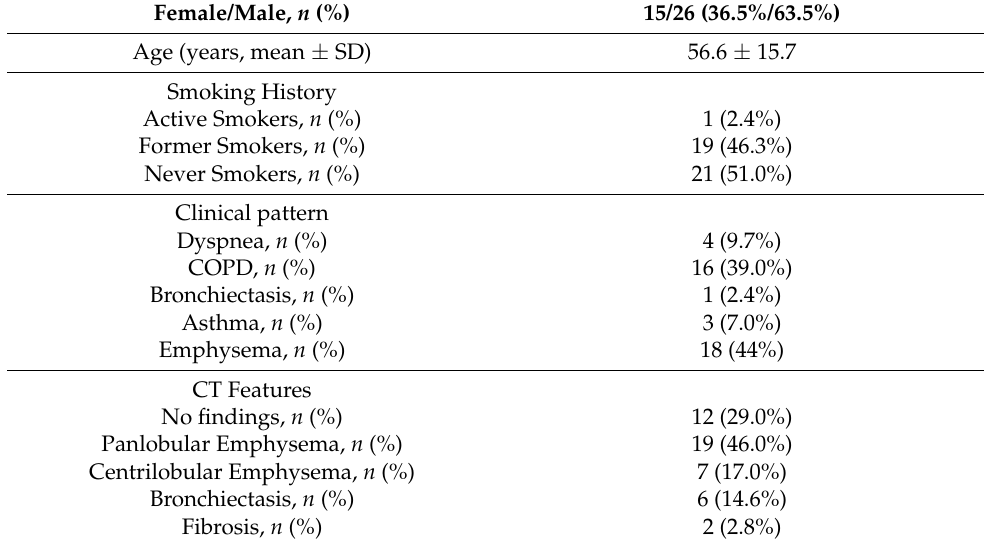
Table 1. Patients’ characteristics. Out of 200 pulmonary patients screened, 141 were found to have alpha1-antitrypsin (AAT) levels less than 120 mg/dL and were subjected to isoelectric focusing for phenotyping of the most common variants and genotyping, while 41 patients presented mutations of the SERPINA1 gene. The demographics and patient characteristics of these 41 patients are listed in this table. COPD = chronic obstructive pulmonary disease; CT = computed